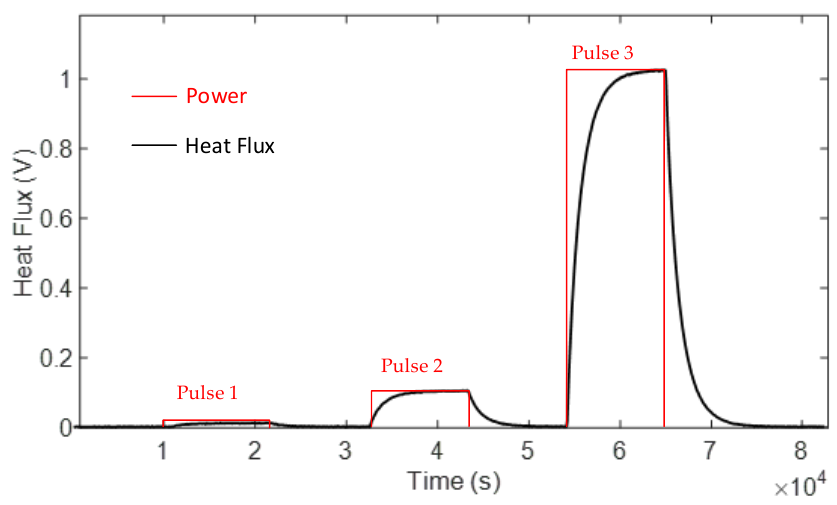
Figure 7. Calibration graph at 20 °C including power pulse and heat flux.